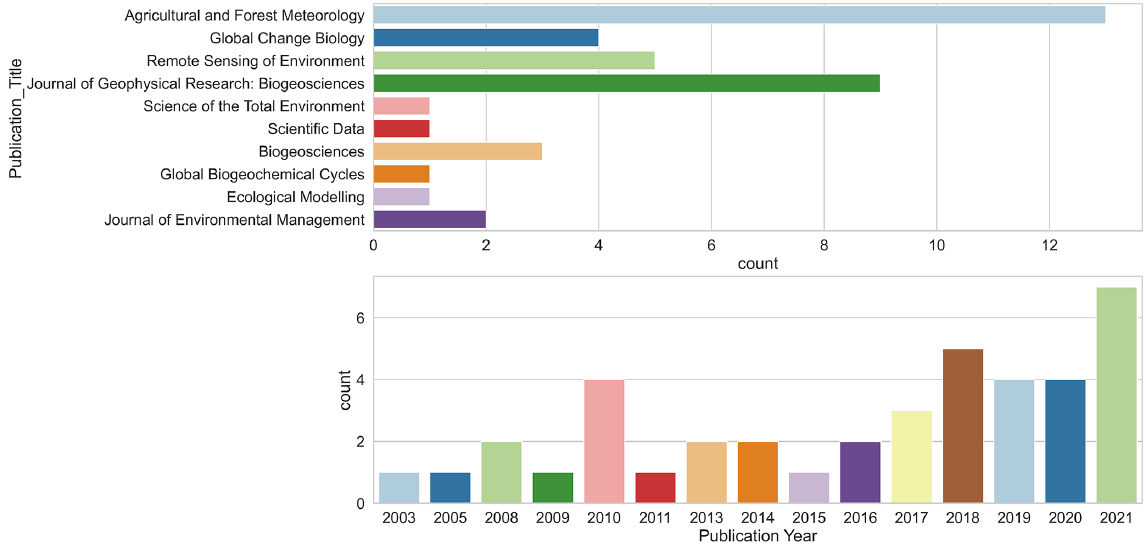
Figure 4. The number of studies published across journals and the total number of publications per